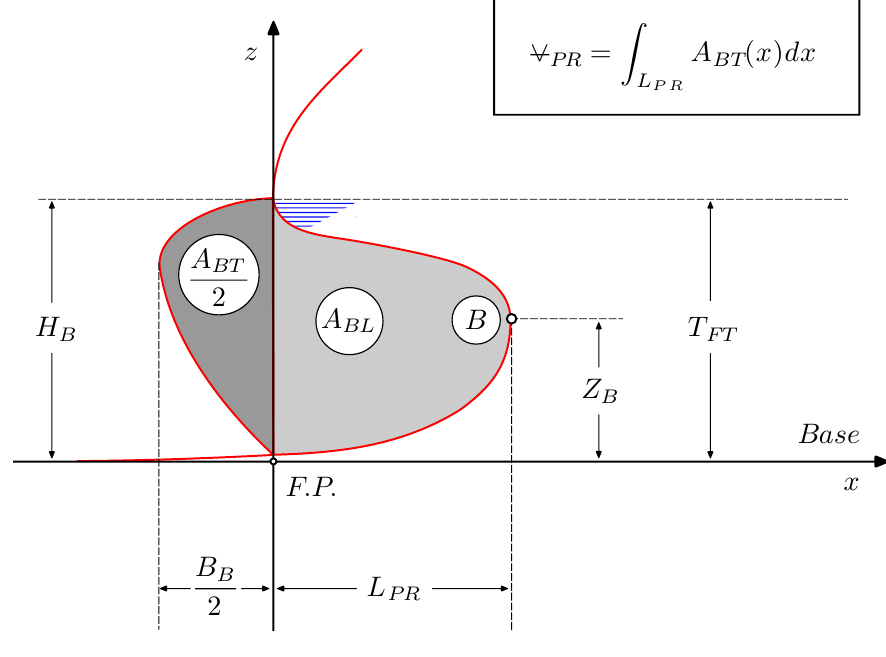
Figure 7. Sketch showing the characteristic lengths used to define the geometry parameters. Adapted from Reference